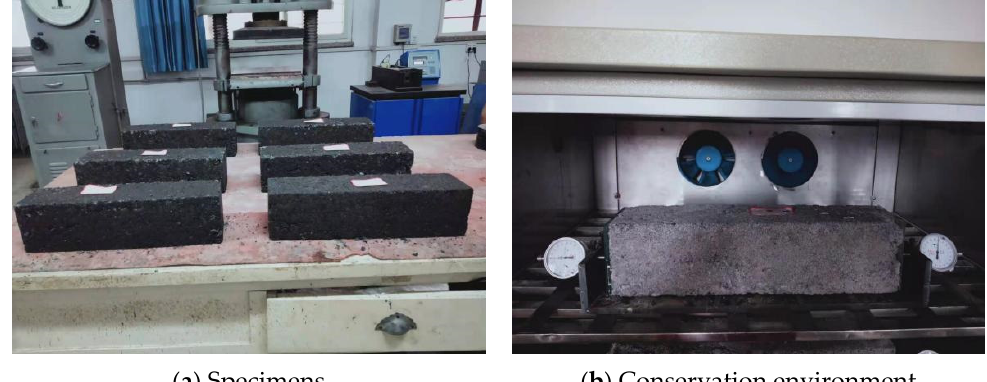
Figure 12. Dry shrinkage test.